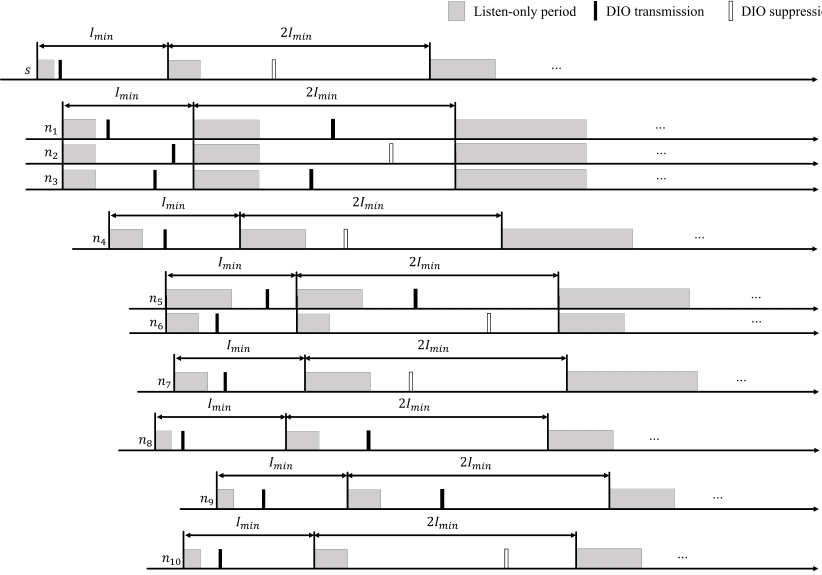
Figure 11. Adaptive listen-only periods for adaptive trickle timer in 3D GVA-P2P-RPL.